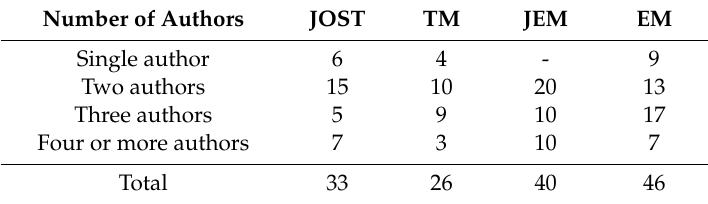
Table 3. Single versus co-authorship of recreational ecology papers (JOST, TM, JEM, EM,